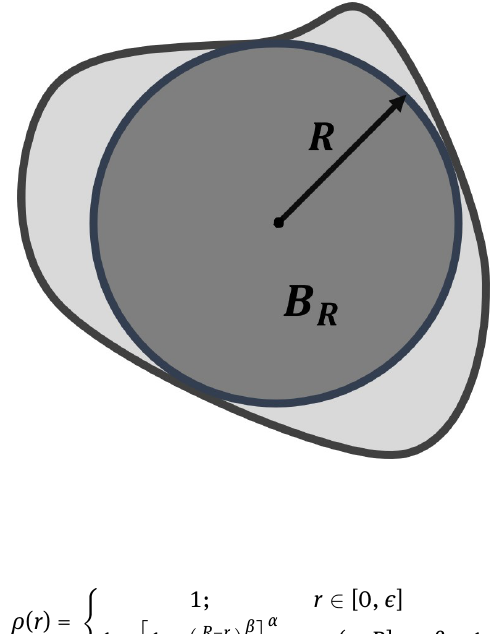
Fig. 5: Largest inscribed ball in Ω